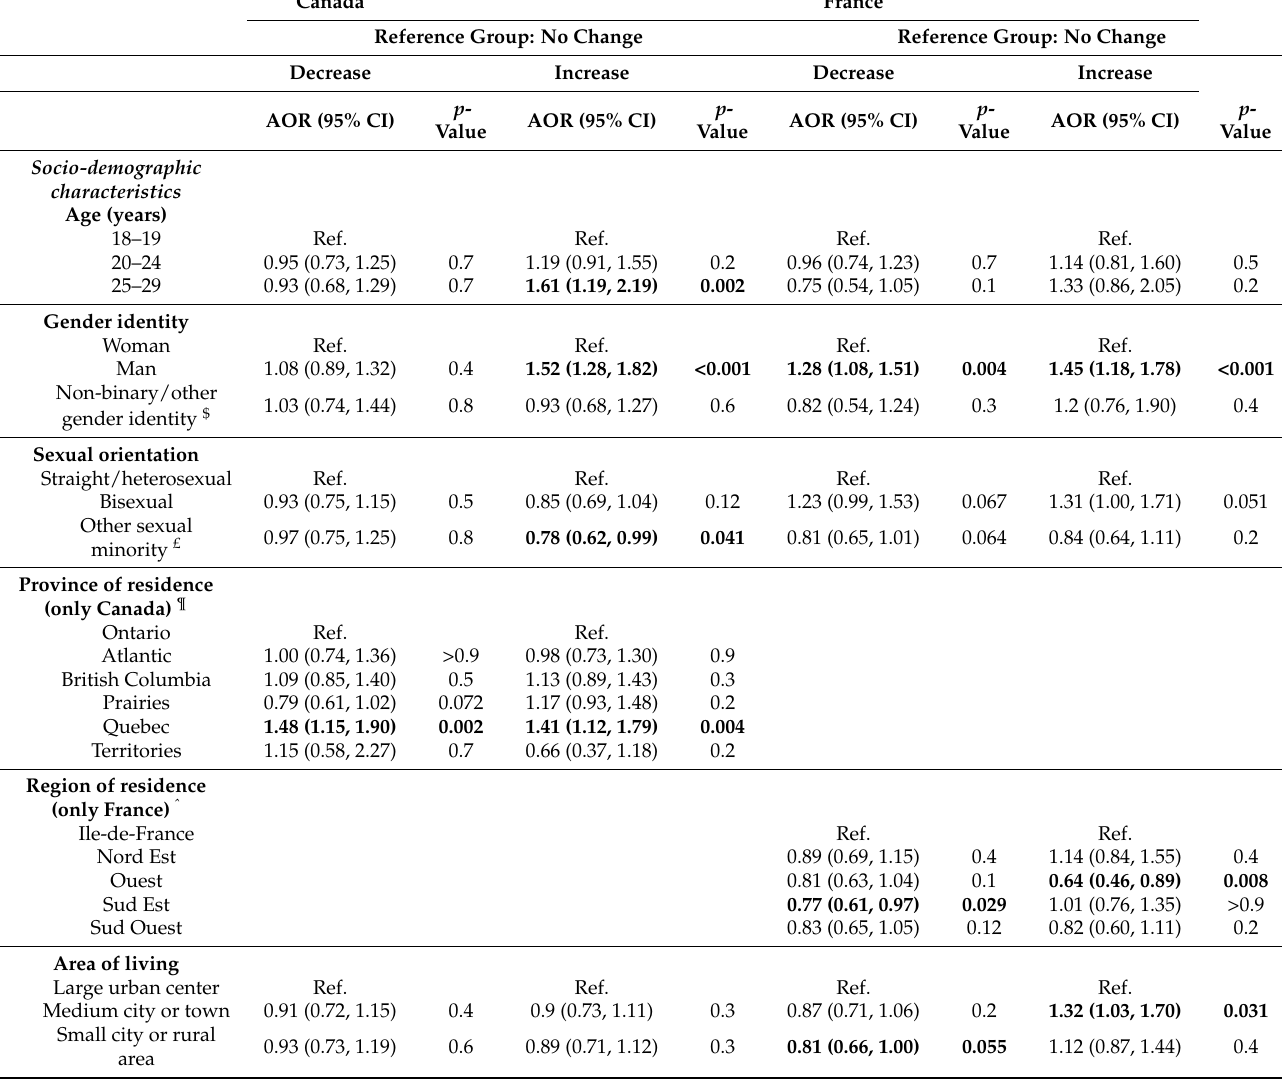
Table 2. Weighted multivariate logistic regression analysis of factors associated with self-reporting a decrease and an increase in alcohol use because of the COVID-19 pandemic among young adults in Canada ( n = 2725) and France ( n = 2328). Canada